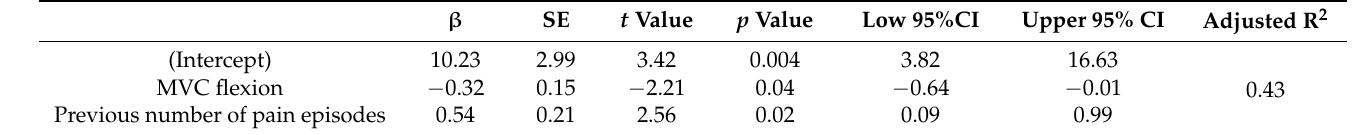
Table 8. Results of multivariate regression analysis showing associations between baseline predictors and number of days with pain (average of 12 months). Table 7. Results of multivariate regression analysis showing associations between baseline predictors and NDI at six months.